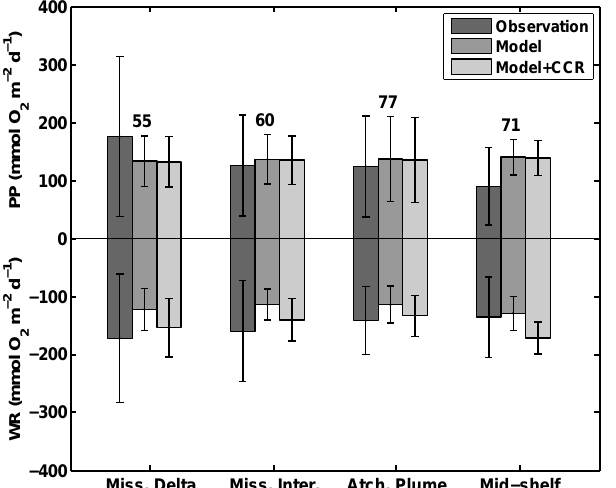
Figure 6. Vertically integrated rates of observed and simulated pri- mary production (upper panel) and water column respiration (lower panel) in the four sub-regions. The error bars indicate the standard deviation. The number of observations in each sub-region is given above the error bars.